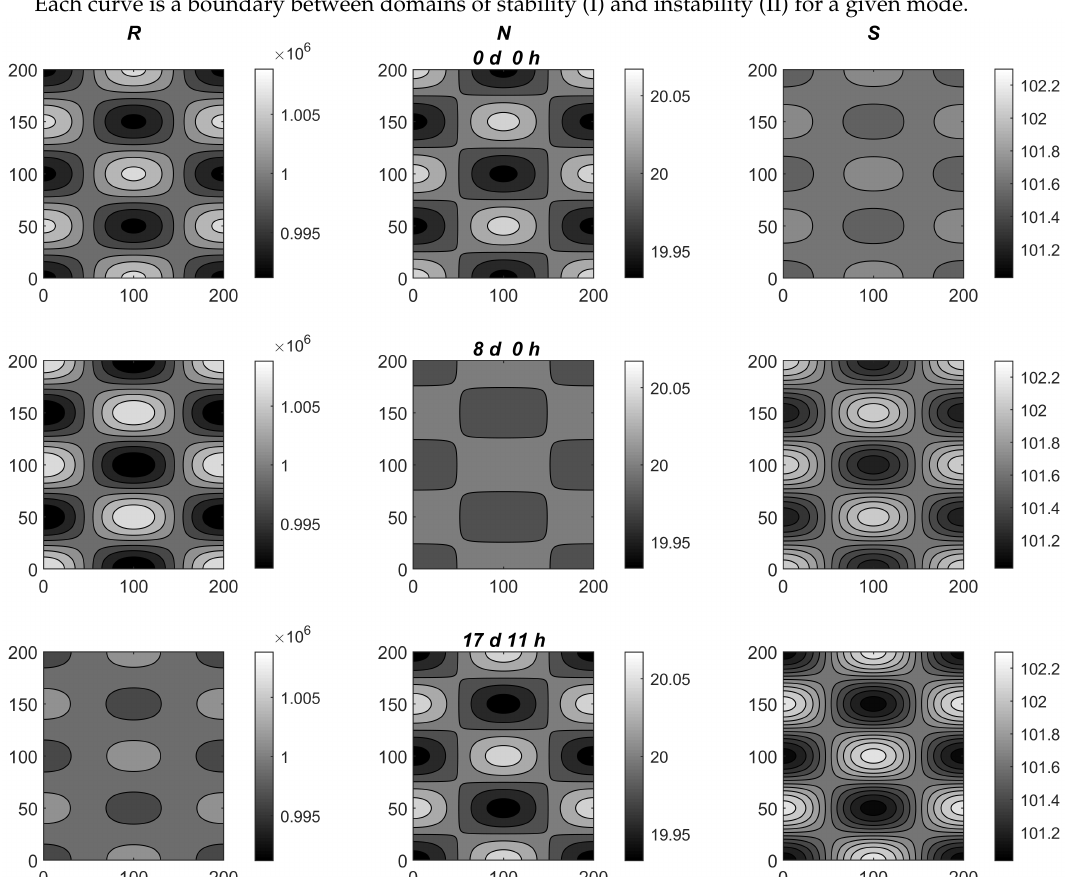
Figure A1. Critical curves on the plane ( (cid:104) N (cid:105) , η ) computed for various spatial modes ( m , p ) according to stability condition (13) for dimensionless model (7)–(10), (16) with parameter values given in Table 4. Each curve is a boundary between domains of stability (I) and instability (II) for a given mode.